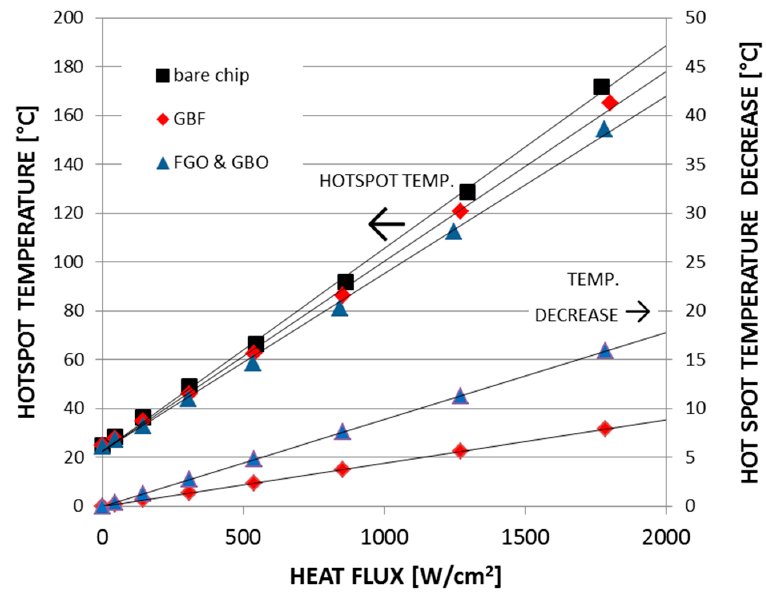
Figure 13. Cooling performance of functionalized graphene-based heat spreaders. Replotted data sourced from Reference [36].